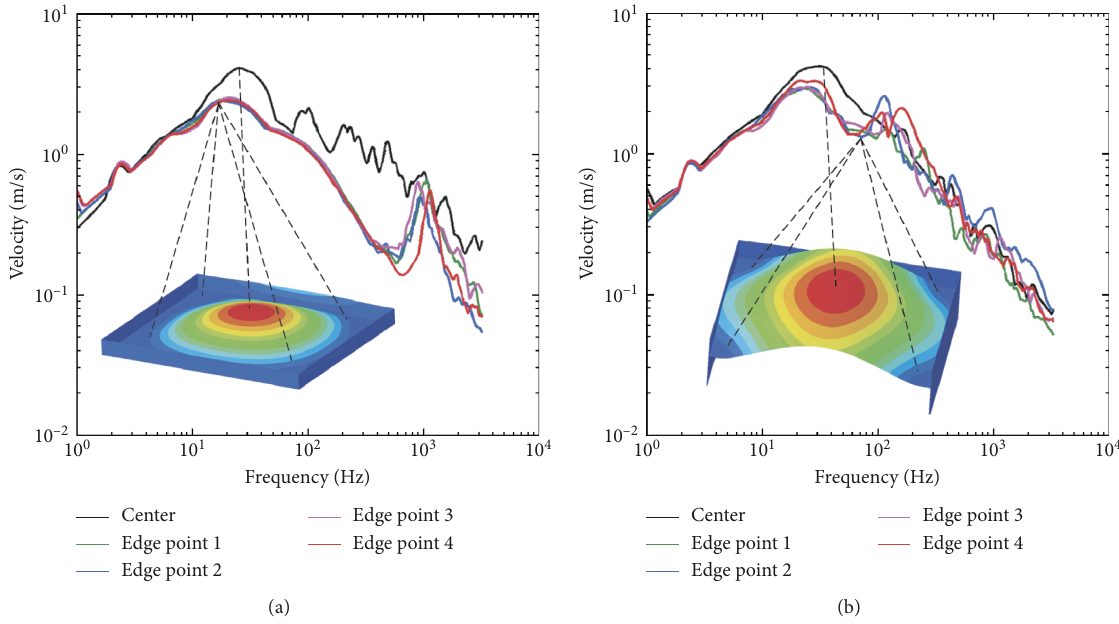
Figure 8: Impact environment in the single plate under working condition 1. (a) Bottom plate. (b) Upside